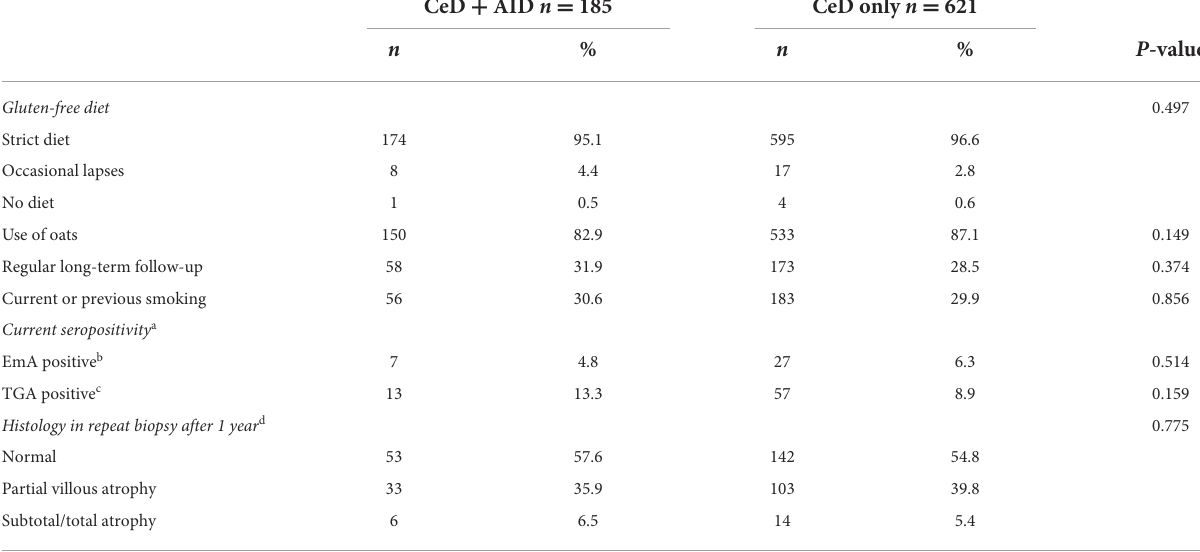
TABLE 2 Follow-up data after a median of 9.7 years on dietary treatment of 806 celiac disease (CeD) patients with or without coexisting autoimmune disease (AID). CeD + AID n =